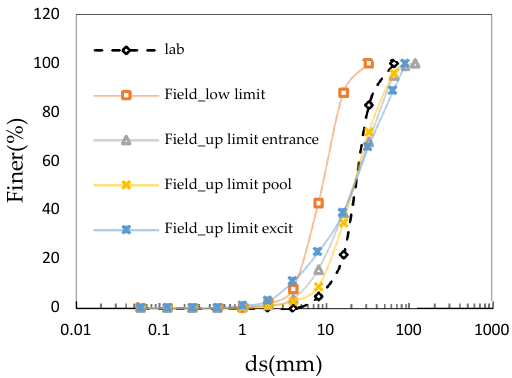
Figure 2. The grain size distribution of bed material in the river and flume.